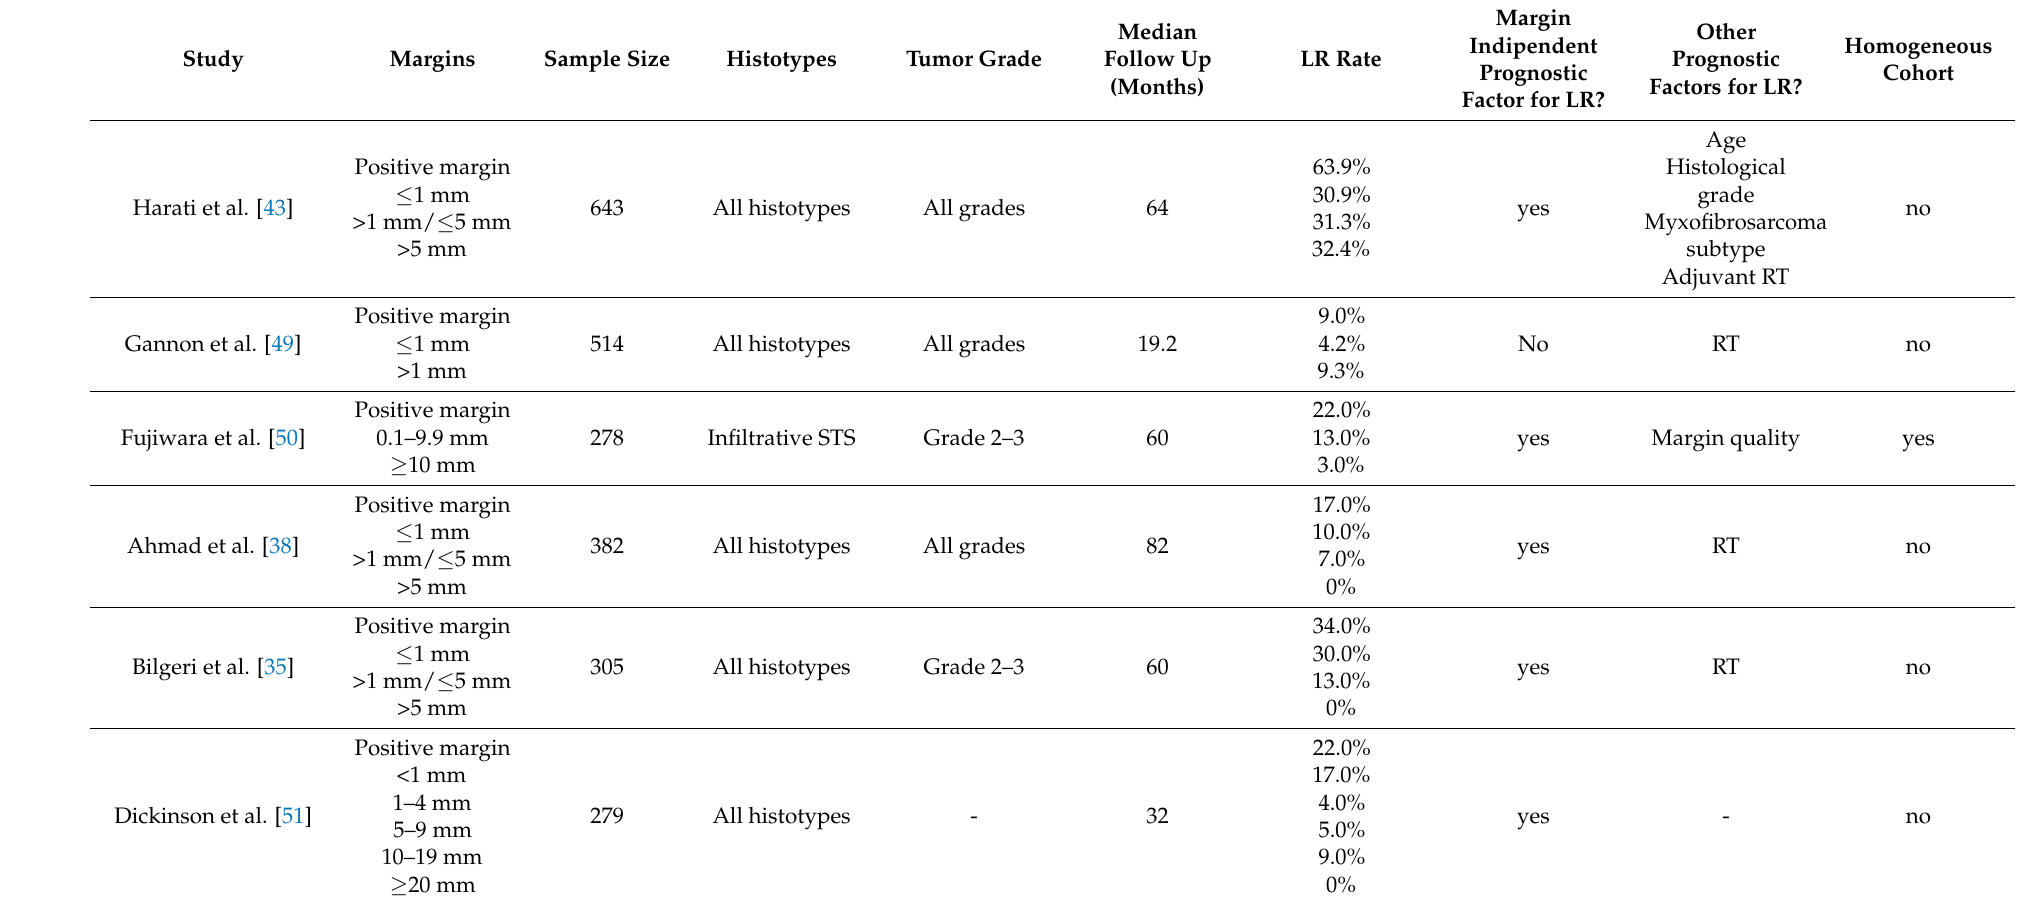
Table 6. Review of the literature. Studies reporting margins based on width margin